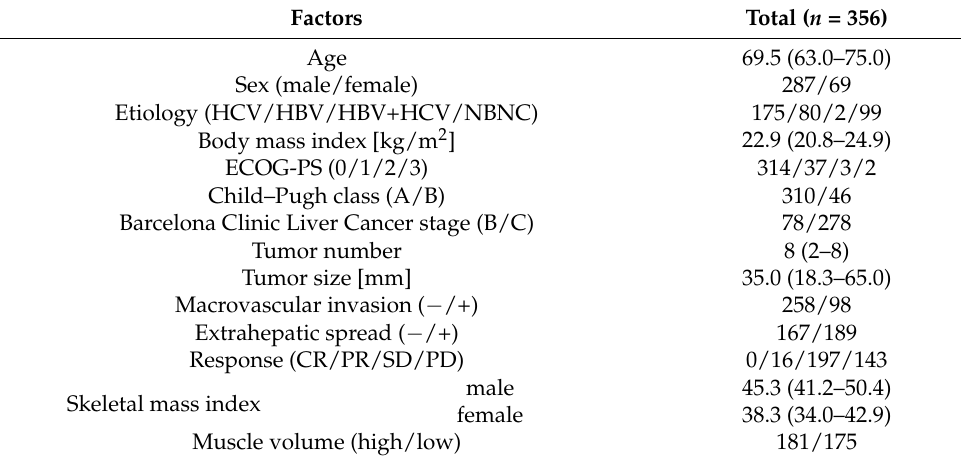
Table 1. Patient